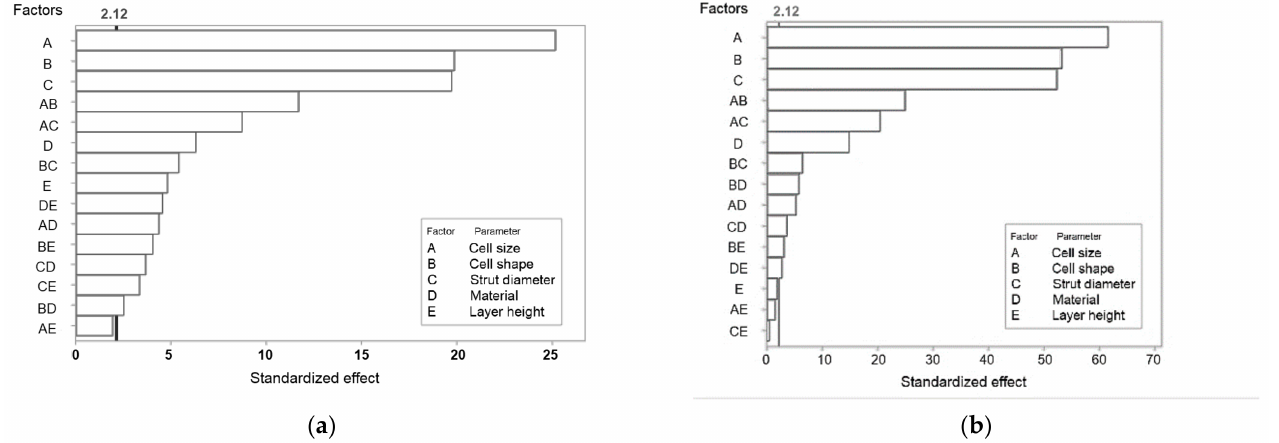
Figure 4. Pareto chart of standardized effects for ( a ) plateau stress, σ pl ; ( b ) elastic modulus. The 2.12 line indicates a significance of the 95% confidence interval ( α = 0.05).